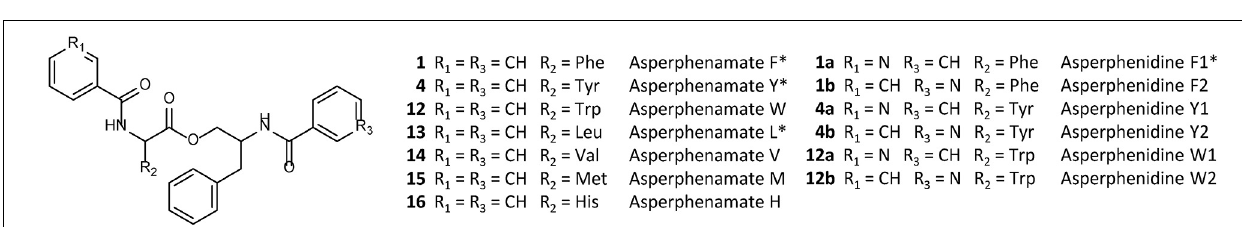
FIGURE 6 | Structural overview and proposed naming system of HRMS/MS characterized asperphenamate analogs from P. astrolabium upon proteogenic amino acid supplement study. Structures marked with asterisk indicate previously reported compounds either of natural or synthetic origin.